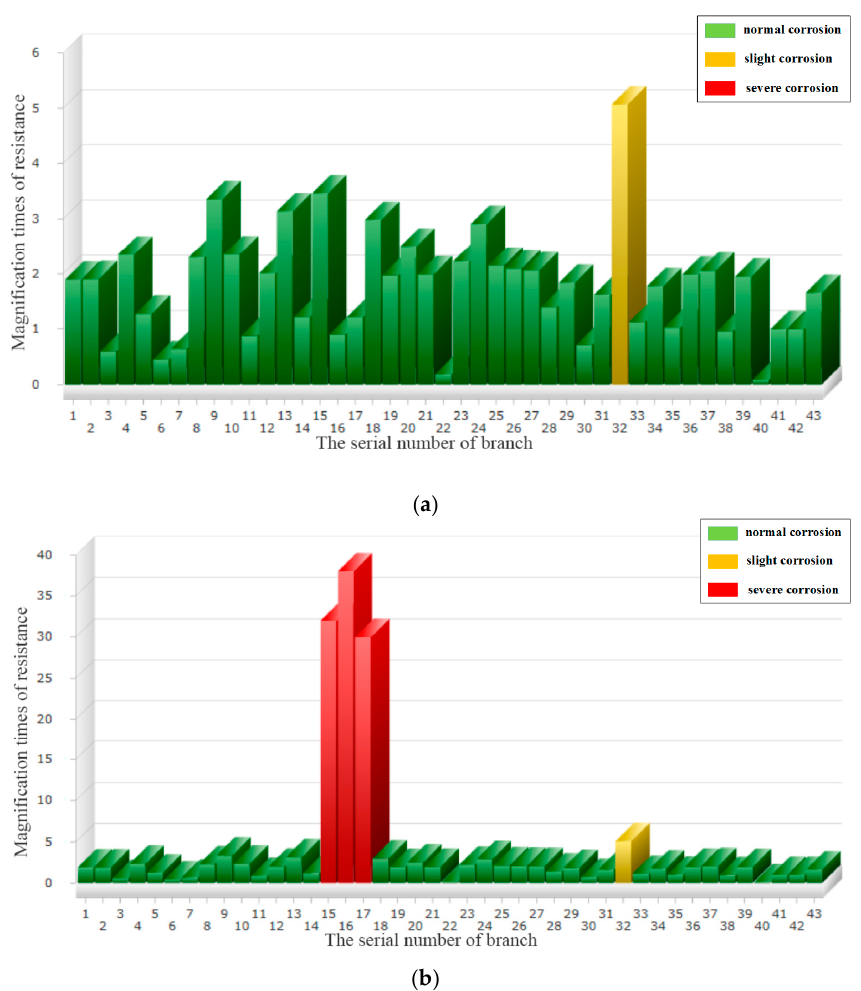
Figure 17. The result in the field experiment. ( a ) The result of pre-fault; ( b ) The result of post-fault.